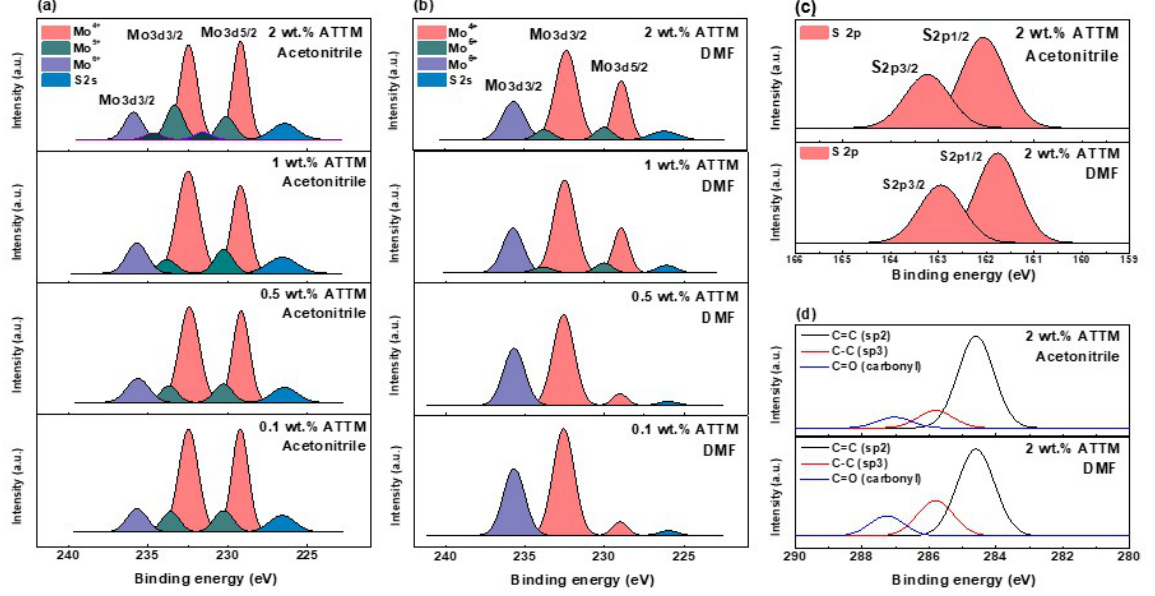
Figure 3. X-ray photoelectron spectra of the MoS 2 –CNW samples: Mo 3d region of ( a ) AM–CNW and ( b ) DM–CNW, ( c ) S 2p region of 2 wt.% ATTM in AM–CNW and DM–CNW, and ( d ) C 1s region of 2 wt.% ATTM in AM–CNW and DM–CNW.